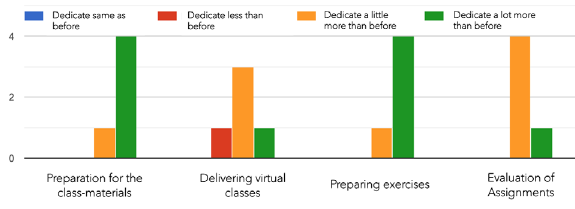
Figure 6. Survey of professors — time distribution — Biological Engineering Workshop 1 at